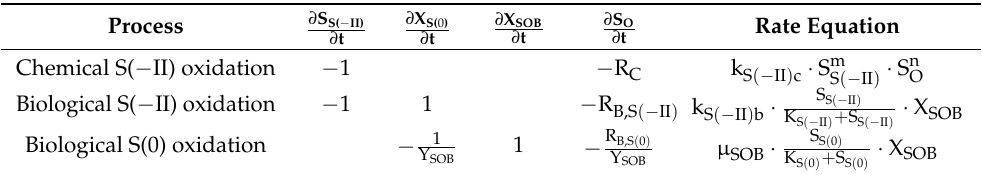
Table 1. Matrix formulation of the process model concept for aerobic transformations of sulfur components during the OUR experiments.